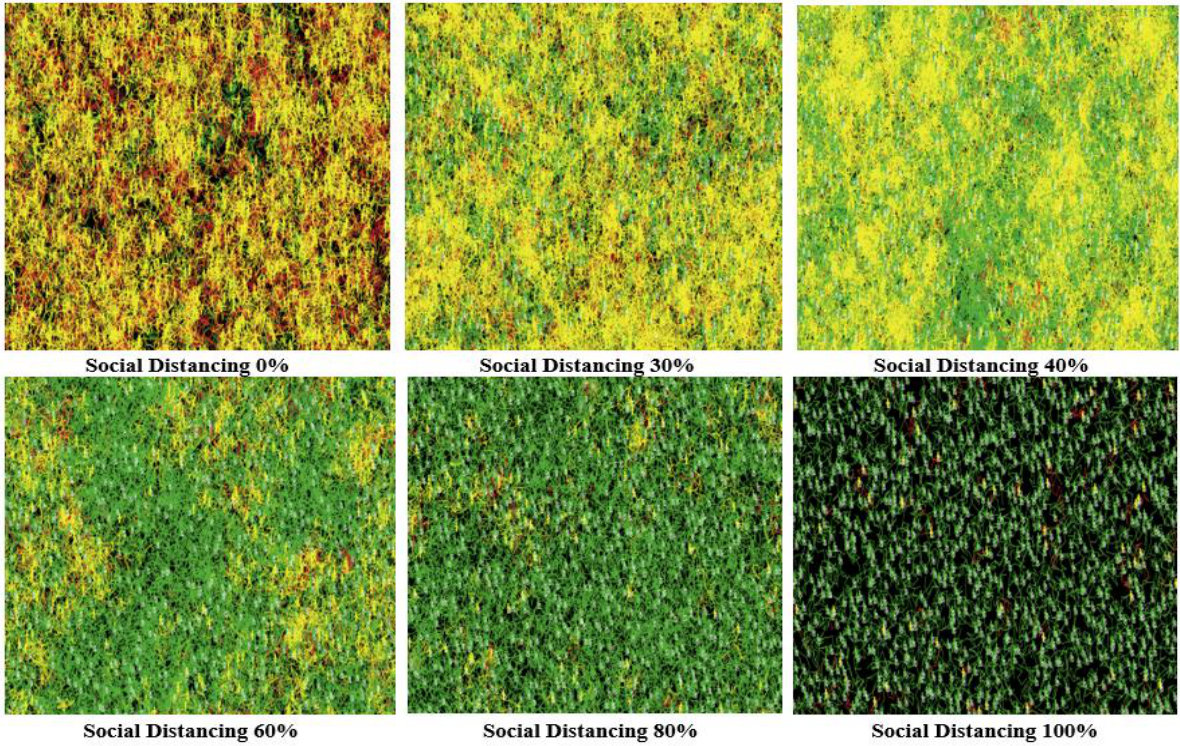
Figure 16. The final visual outputs of applying different levels of social distancing (with tracing individuals’ movement).